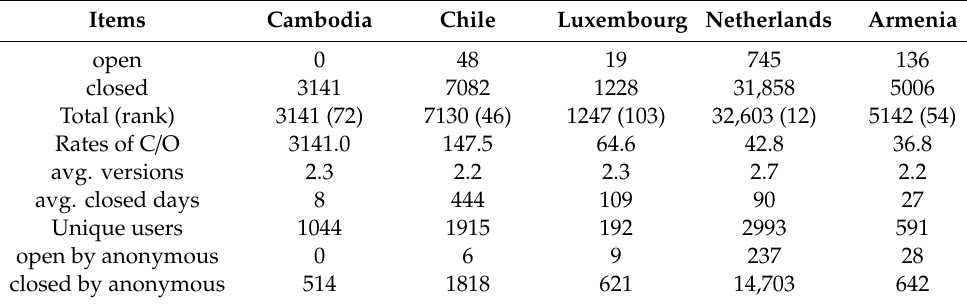
Table 5. Top 5 countries with high open / closed rates of OSM Notes.